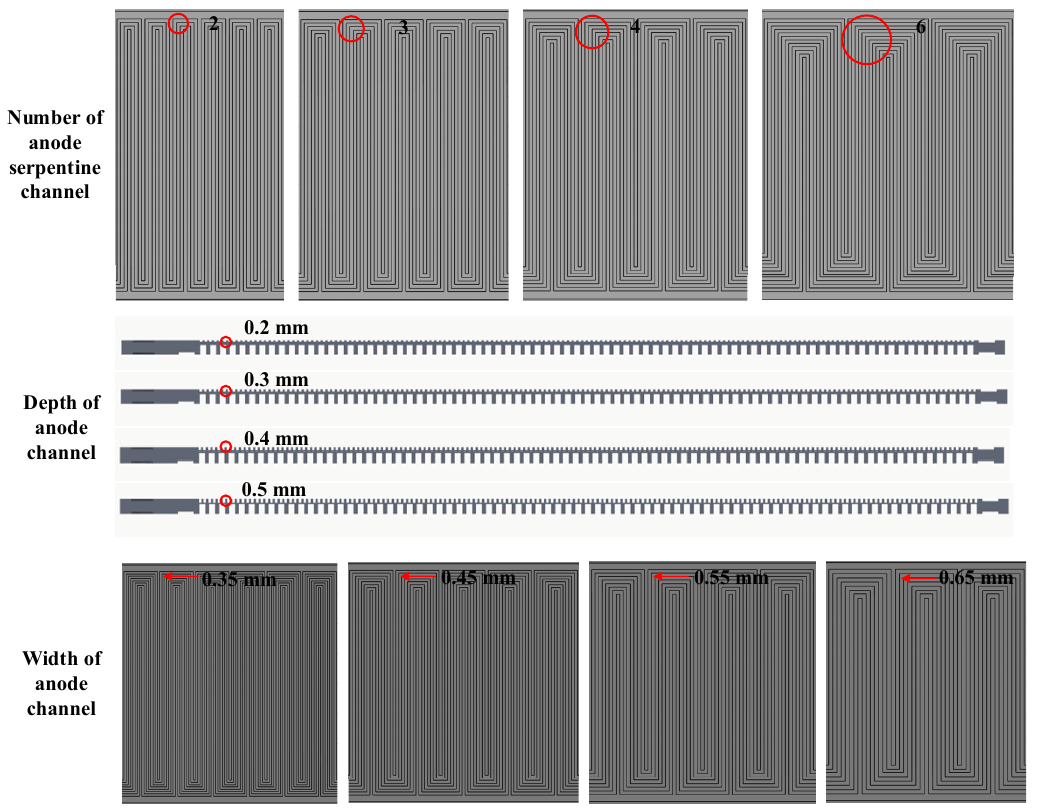
Figure 1. Schematic of anode flow field design with different channel numbers, depths, and widths of the anode serpentine flow field. Table 1. Parameters of different anode serpentine flow fields for open-cathode PEMFC.